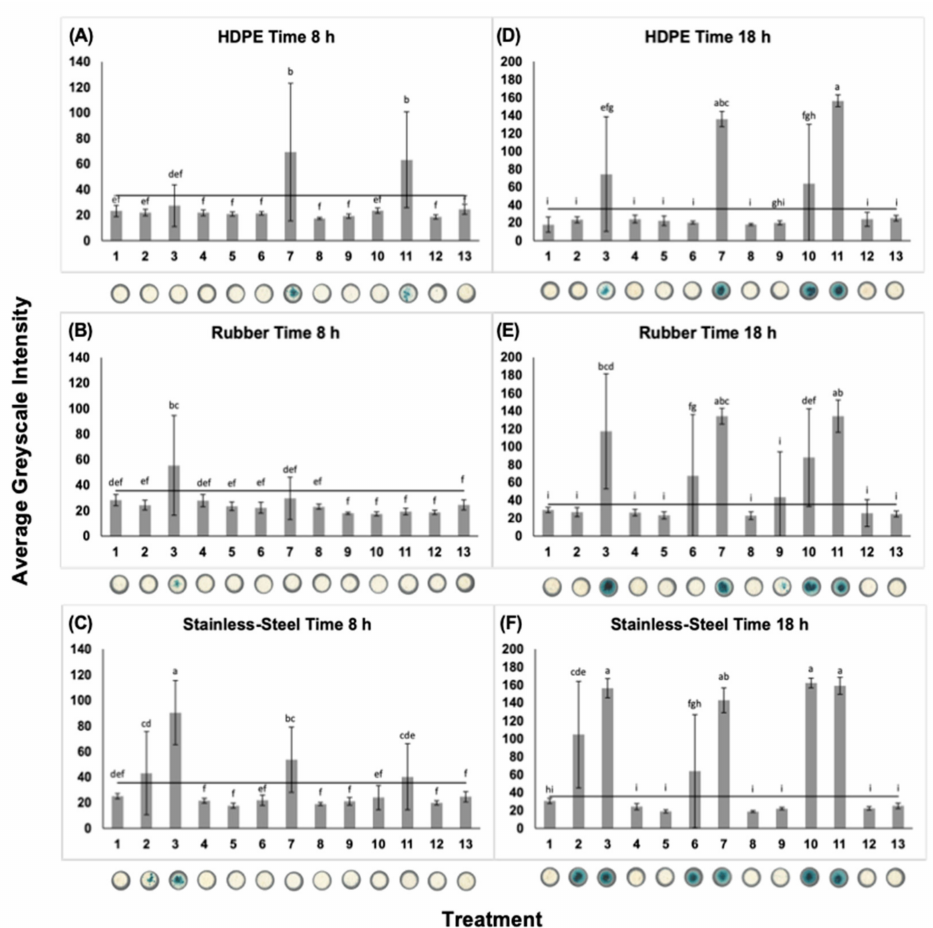
Figure 4. Detection of L. monocytogenes on food contact and non-food contact surfaces using enzy- matic colorimetric detection paired with a µ PAD platform. Enrichment time points at eight (left panel) and 18 h (right panel) are depicted. After 18 h enrichment, detection of L. monocytogenes on a µ PAD platform is clearly discernable upon visual inspection. The average greyscale intensity was determined using ImageJ. The threshold value is represented in black. Bars show standard deviations of three means. Means with different letters are significantly different. Digitized colori- metric images. Representative wells are depicted. From top to bottom: ( A , D ) HDPE, ( B , E ) rubber, ( C , F ) stainless-steel. From left to right on the x-axis are the following treatments: (1) L. monocyto- genes 1 CFU/coupon calcium alginate swab, (2) L. monocytogenes 10 CFU/coupon calcium alginate swab, (3) L. monocytogenes 10 2 CFU/coupon calcium alginate swab, (4) B. pumilus 10 2 CFU/coupon calcium alginate swab, (5) L. monocytogenes 1 CFU/coupon rayon-tipped swab, (6) L. monocyto- genes 10 CFU/coupon rayon-tipped swab, (7) L. monocytogenes 10 2 CFU/coupon rayon-tipped swab, (8) B. pumilus 10 2 CFU/coupon rayon-tipped swab, (9) L. monocytogenes 1 CFU/coupon sponge- stick, (10) L. monocytogenes 10 CFU/coupon sponge-stick, (11) L. monocytogenes 10 2 CFU/coupon sponge-stick, (12) B. pumilus 10 2 CFU/coupon sponge-stick, (13) uninoculated